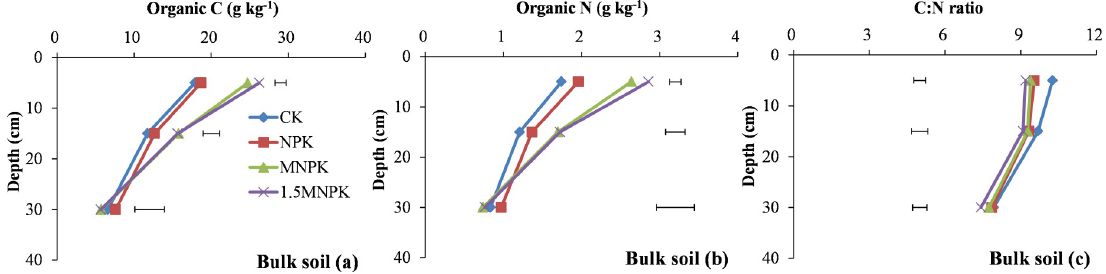
Fig 1. Soil organic C and N concentrations and their C/N ratios in bulk soil in the control (CK), chemical fertilizer (NPK), and combined manure and chemical fertilizer (MNPK, 1.5MNPK) treatments in the top 40 cm of the soil profile. Values at each soil depth are the mean of three replicates. The horizontal lines denote the least significant difference values at the 0.05 level (LSD0.05) among different treatments at each soil depth. LM, SM, free-m, and free-SC represent large macroaggregates ( > 2000 μ m), small macroaggregates (2000–250 μ m), microaggregates (53–250 μ m), and silt-clay ( < 53 μ m); cPOM, inter-m, and inter-SC represent coarse particulate organic matter (POM), microaggregates within macroaggregates, and silt-clay within macroaggregates; fPOM, fiPOM, and intra-SC represent fine POM, fine intra POM and intra silt-clay within